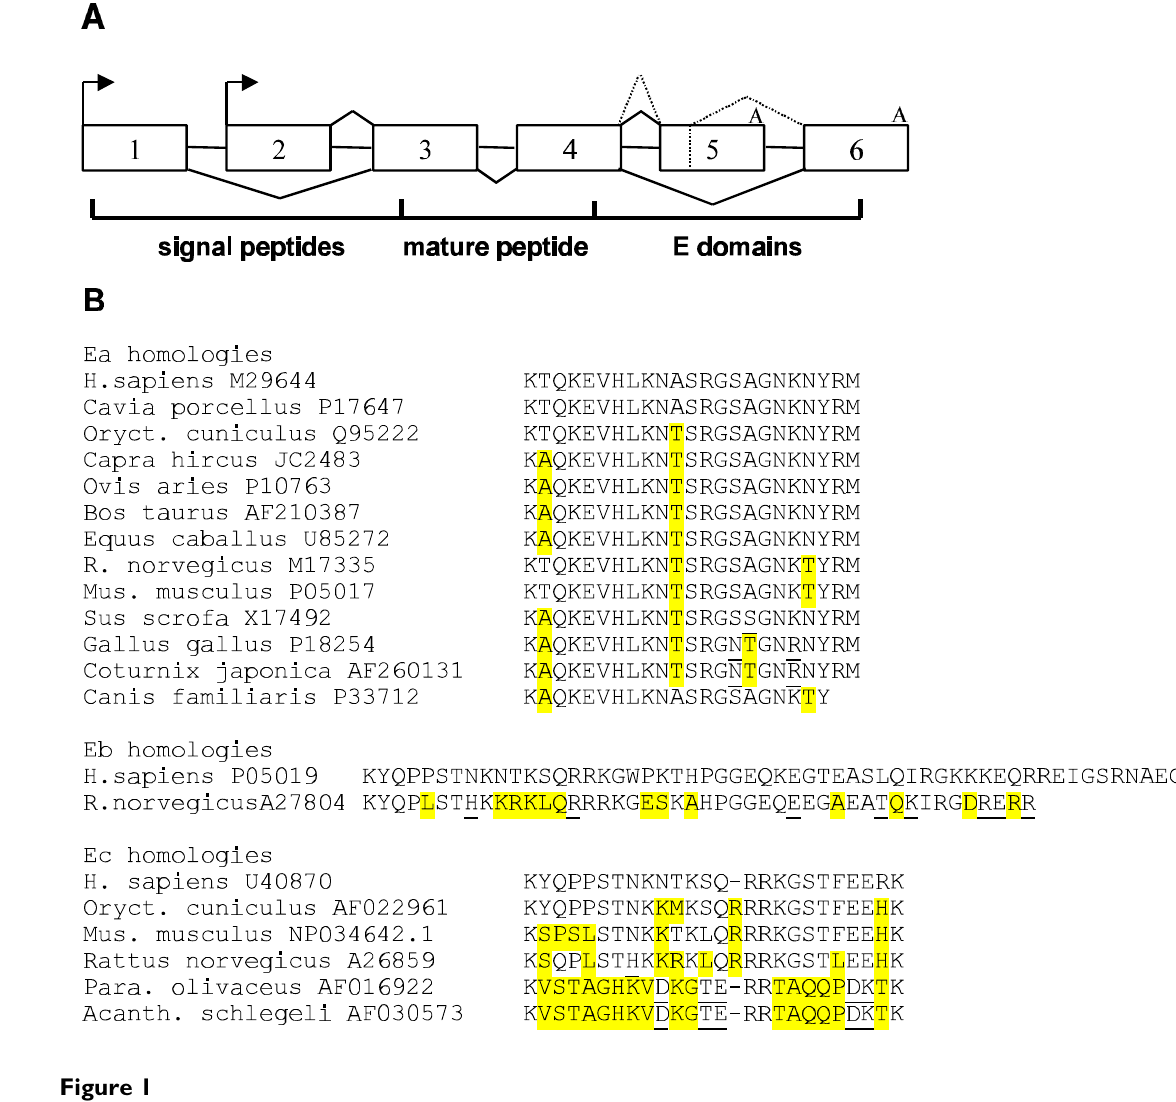
Figure 1 (A) Alternative splicing of the human IGF-I gene. Exons are shown as boxes, introns as lines, transcription start sites as arrows, splicing patterns as sloped lines, and polyadenylation signals as the letter A. The protein coding potential of the exons is indi- cated underneath. (B) Alignment of predicted alternative E domains. Species are given on the left; non-homologous residues are highlighted in yellow; similarities are